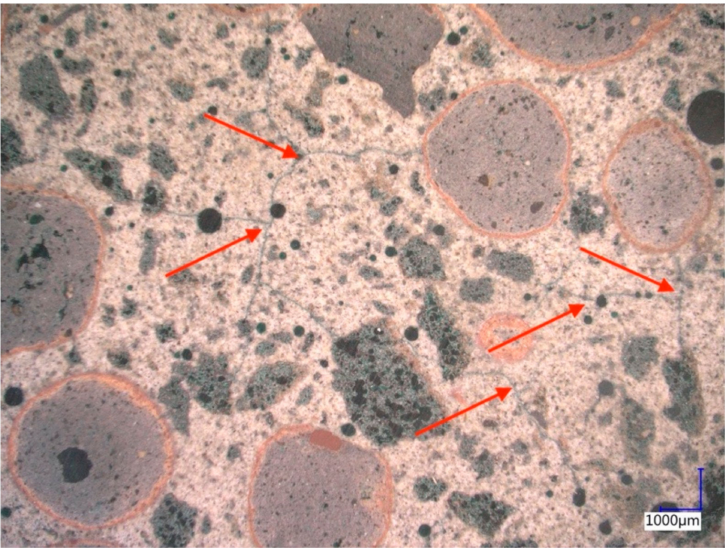
Figure 3. Severe formation of microcracks in the matrix (marked with red arrows) of a high strength LC due to water absorption of fine and coarse LWA (Courtesy: Andrea